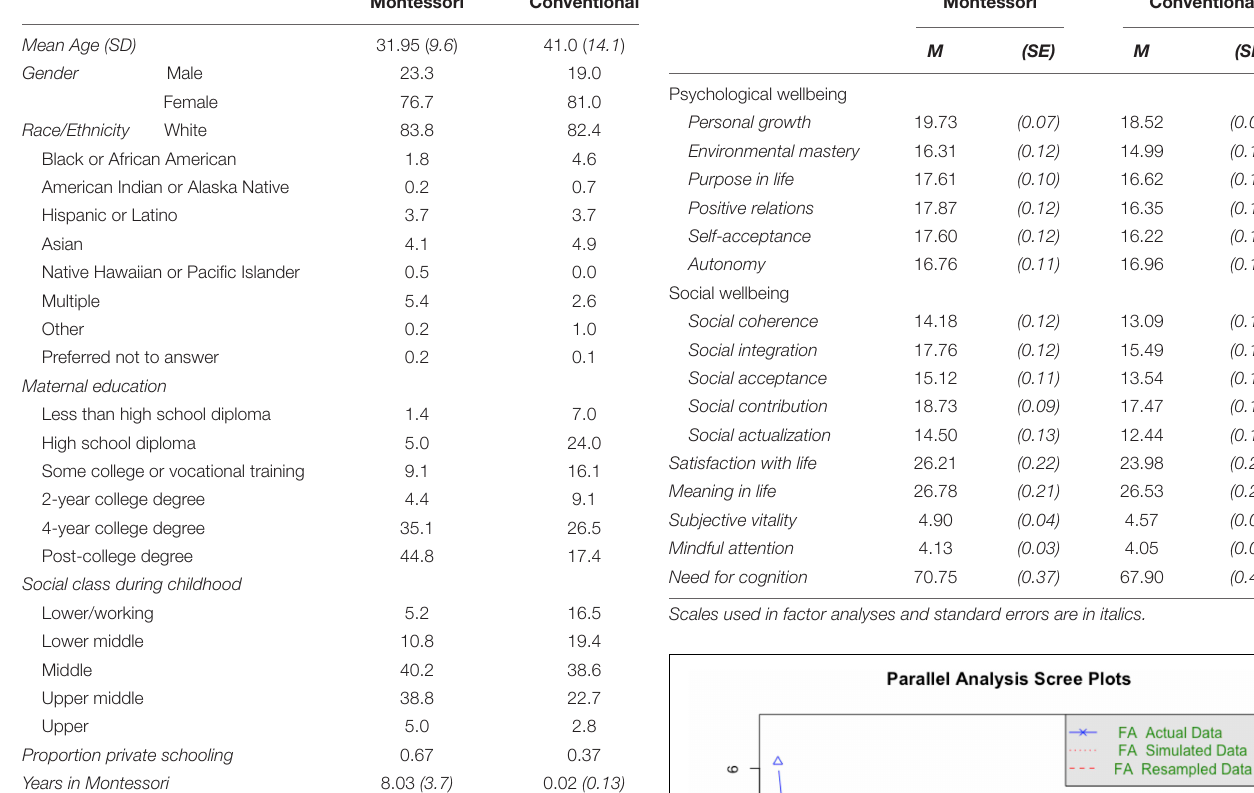
TABLE 1C | Untransformed means and standard errors for Montessori and conventional samples. Montessori Montessori Conventional